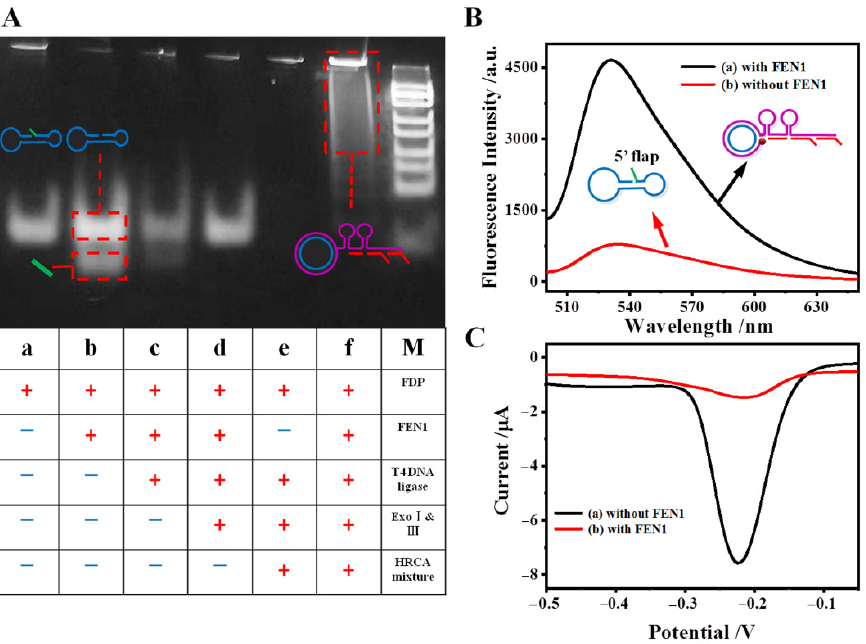
Figure 1. Feasibility study. ( A ) Polyacrylamide gel electrophoresis under different conditions: (a) FDP, (b) FDP + FEN1, (c) FDP + FEN1 + T4, (d) FDP + FEN1 + T4 + Exo I and III, (e) FDP + T4 + Exo Ⅰ and Ⅲ + HRCA mixture, (f) FDP + FEN1 + T4 + Exo I and III + HRCA mixture, (M) marker. ( B ) Fluorescence spectra at present and absence of FEN1: (a) with FEN1, (b) without FEN1. ( C ) The DPV responses with and without target: a) without FEN1; (b) with FEN1. The concentrations of FEN1 and FDP are 80 U/L and 5 nM, respectively.